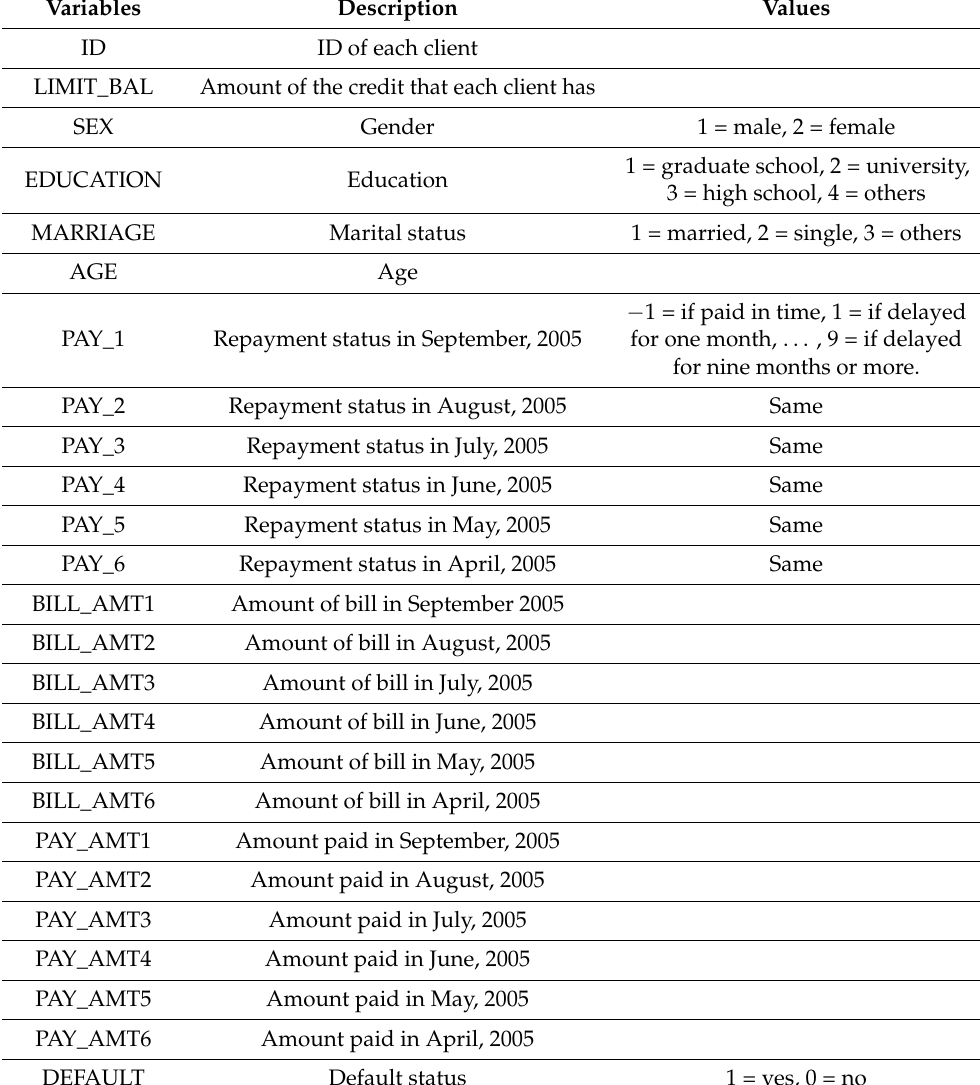
Table 2. The description of the database